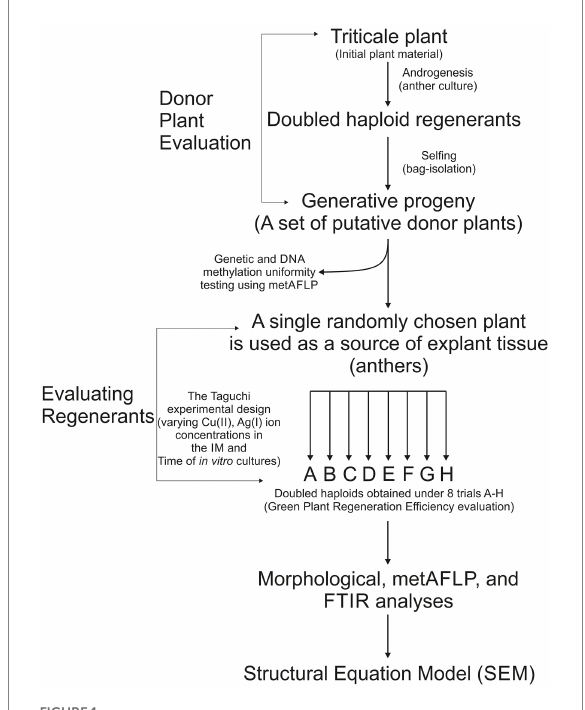
FIGURE 1 Plant material evaluation and analysis. A randomly chosen plant of triticale was used as a source of tissue explants (anthers) to obtain doubled haploid (DH) plants that were self-isolated (bagged) to obtain generative progeny (a set of putative donor plants). The progeny was analyzed via the metAFLP approach for the sequence variation and DNA methylation pattern uniformity. A single randomly chosen progeny (donor plant) was used as a source of anthers to obtain regenerants under the varying concentration of Cu(II), Ag(I) present in the IM, and different Time of in vitro anther cultures according to the Taguchi experimental design. In total, eight such experiments were conducted where the A one reflected control conditions and the B-H required by the approach. The regenerants for each trial were counted, and GPRE was evaluated. Visual morphological inspection, metAFLP, and Fourier Transform Infrared (FTIR) analyses were performed for each regenerant, and the evaluated data was implemented for structural equation